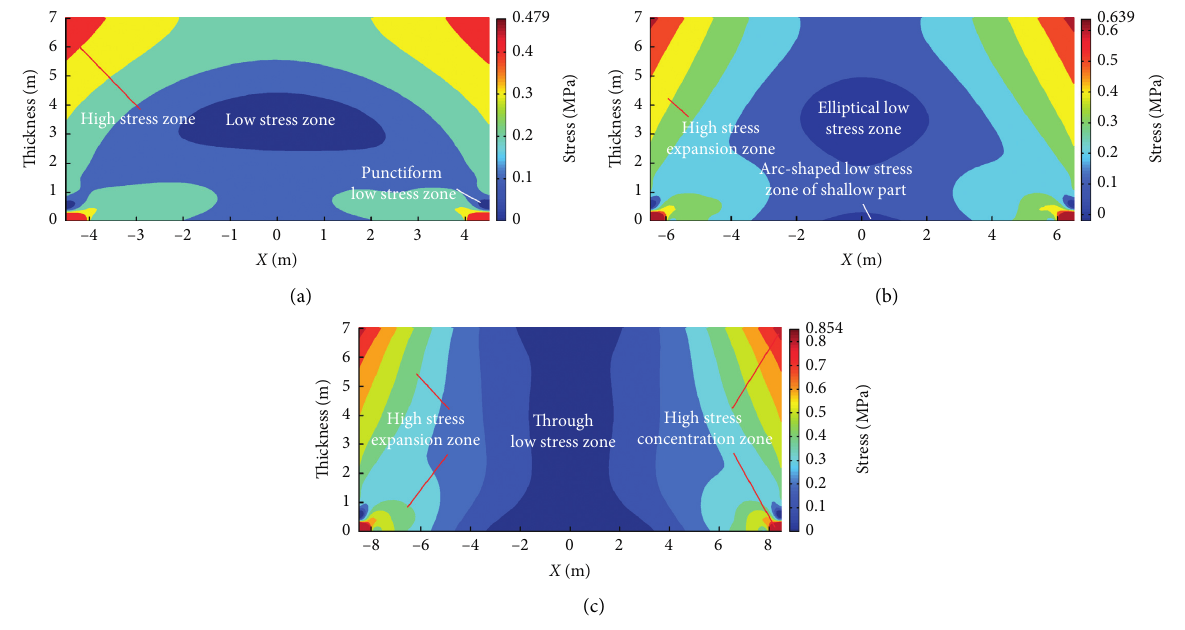
Figure 11: MSS distributions with different ARBBS spans. (a) l � 9 (m), (b) l � 13 (m), and (c) l � 17m.